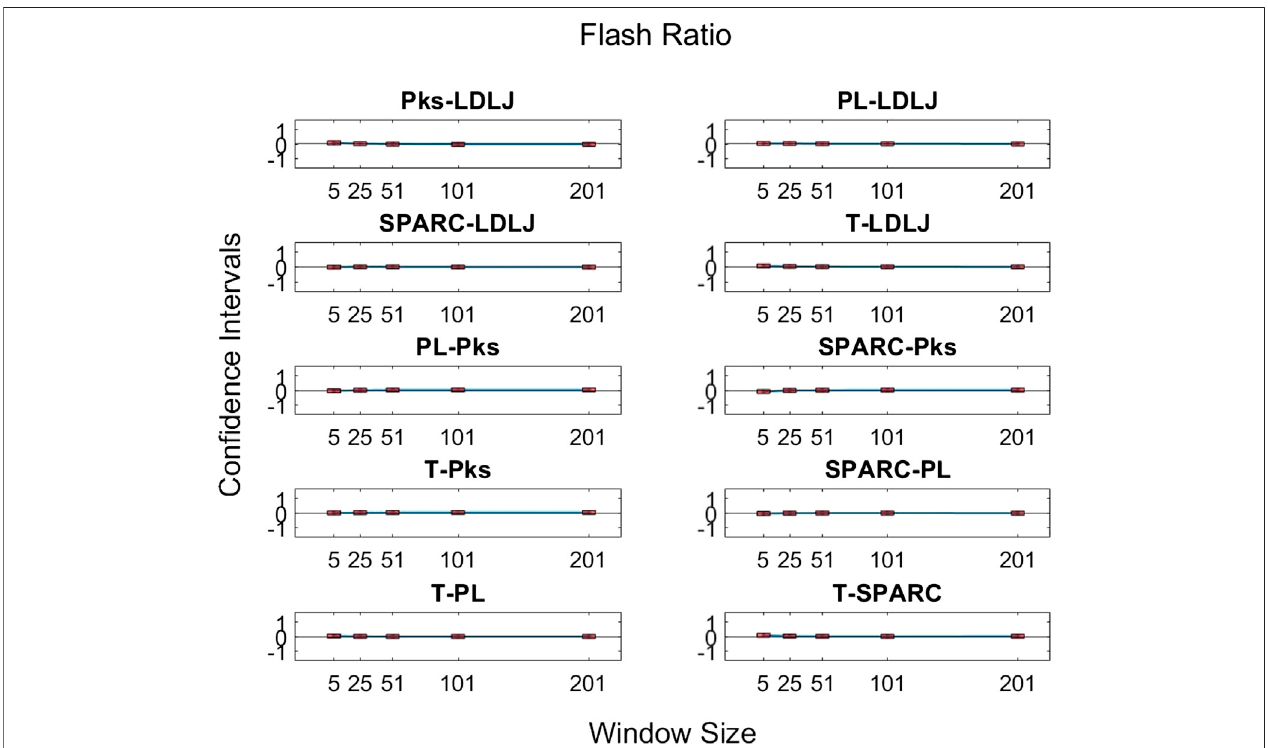
FIGURE 11 | Con fi dence intervals of pairwise comparisons of process metrics with respect to FR plotted against all tested window spans. To visualize the relationships between effects sizes of process metrics and window spans, a line is plotted through the point estimates. A horizontal line is drawn through 0. If the con fi dencelimitsarebothabovezero,theminuendismorestronglyassociatedwith FR ;ifthelimitspassthroughzero,thedifferencesareinsigni fi cant;andifthelimitsare below zero, the subtrahend is more strongly associated with FR .